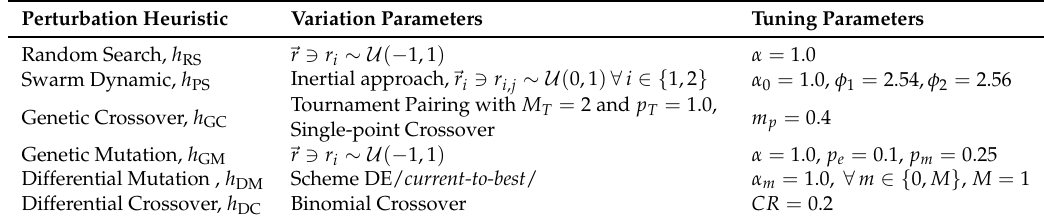
Table 3. Parameters chosen for each implemented perturbator.